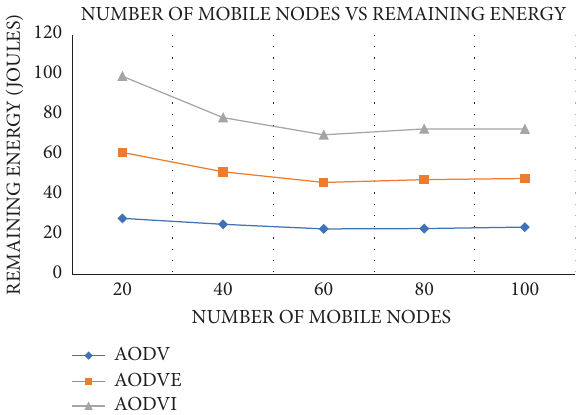
Figure 12: Number of mobile nodes vs remaining energy.